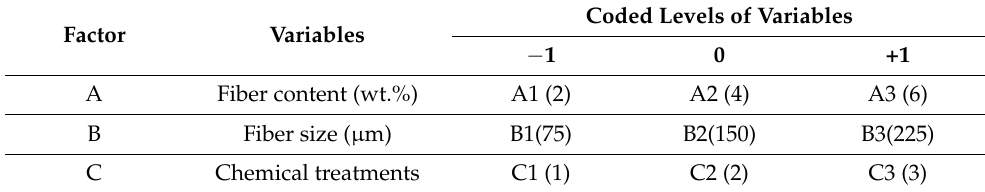
Table 1. Levels and codes preferred for Box–Behnken